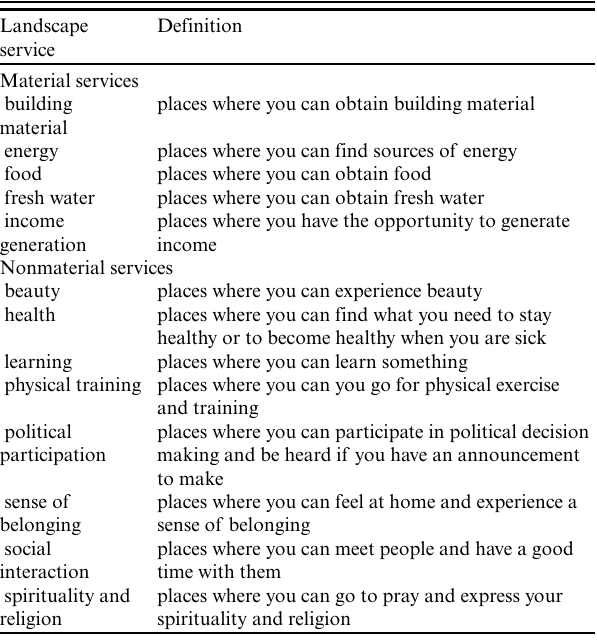
Table 1 . Categories of services and definitions used for participatory